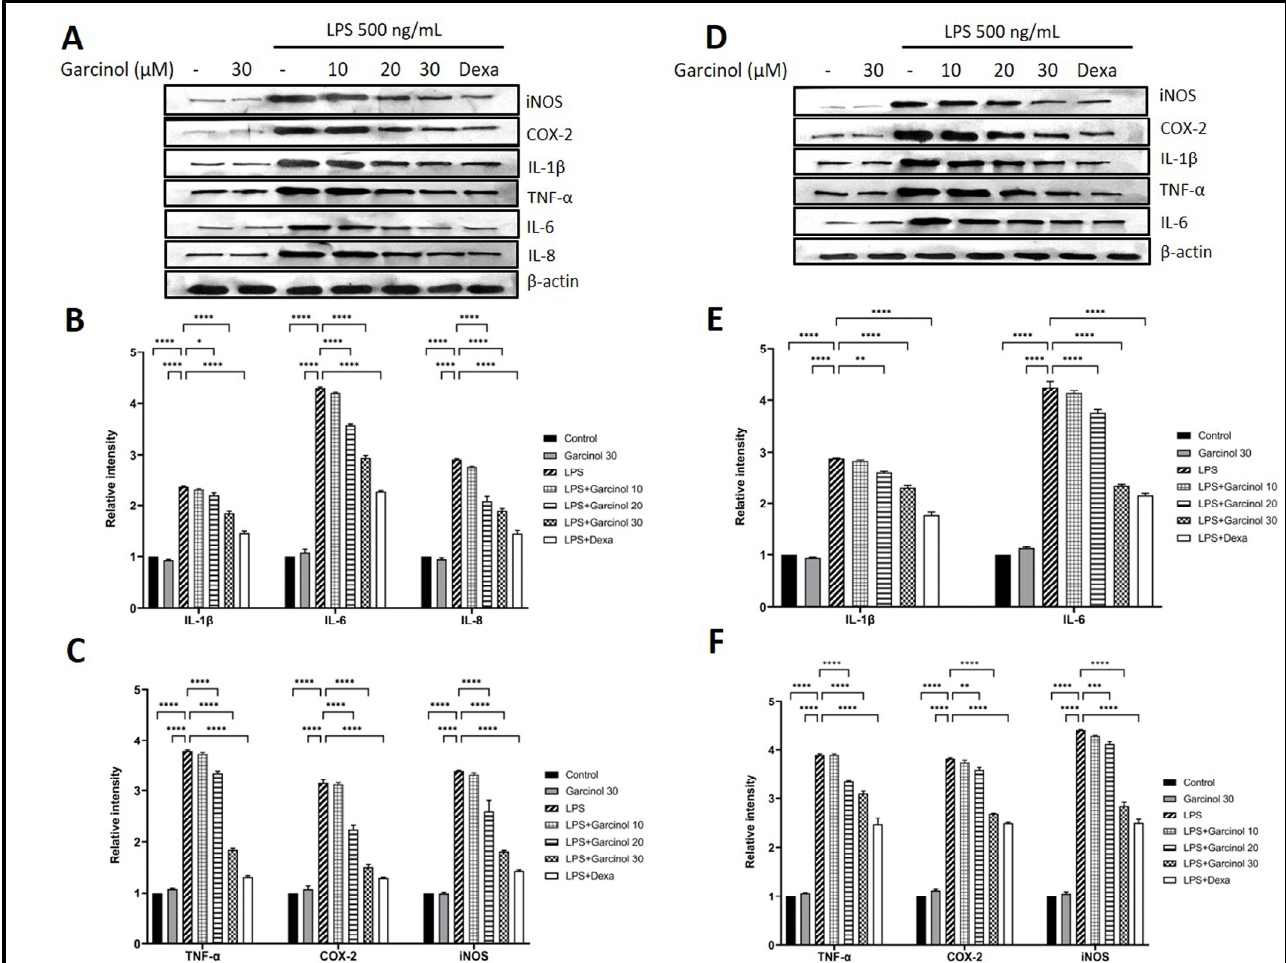
Figure 4. Effects of garcinol (10, 20, and 30 µ M) on the protein expression level of a pro-inflammatory- related molecule including TNF- α , iNOS, COX-2, IL-8 IL-6, and IL-1 β in THP-1 cells ( A – C ) and RAW264.7 cells ( D – F ) activated with 500 ng/mL of LPS. Western blot analysis was used to determine the protein expression, and β -actin was used for normalization. The data are presented in the three independent experiments(cid:31) mean ± SD of triplicate examination ( n = 9). For statistical analyses, One- way ANOVA and Dunne tt (cid:31)s test were used. * p < 0.05, ** p < 0.01, *** p < 0.001, **** p < 0.0001.